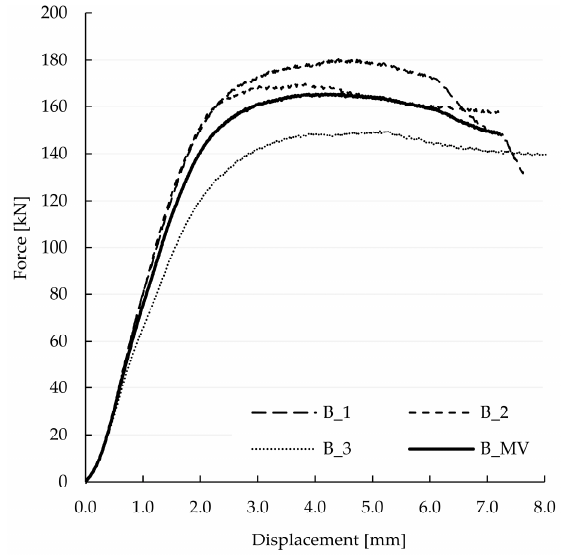
Figure 19. Force-displacement curves of all three single-step specimens, as well as the mean value MV of the three specimens.